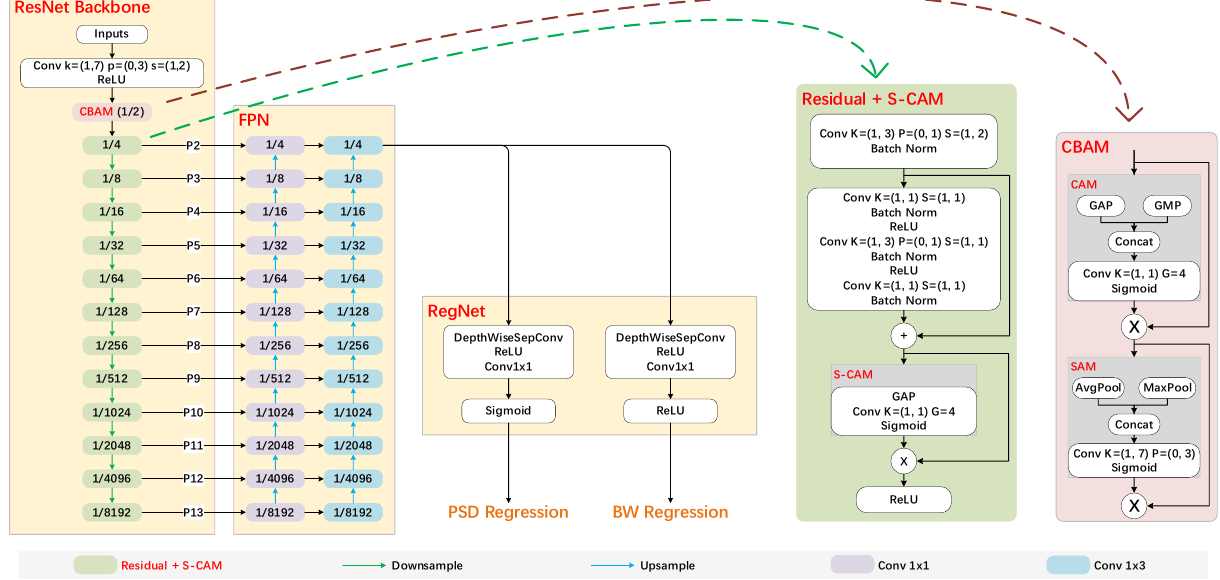
Figure 3. The architecture of SCN-13× includes three main parts, the residual backbone, the FPN neck, and the RegNet head.